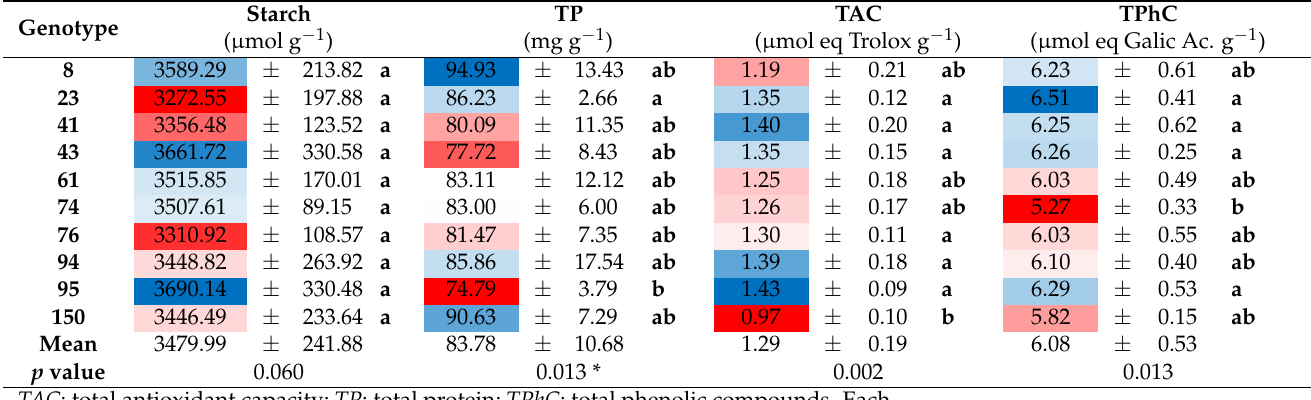
Table 2. Non-mineral nutrients (starch and total protein concentrations, total antioxidant capacity and total phenolic compound concentration) in wheat grains of 10 wheat genotypes grown under elevated CO 2 and high temperature.